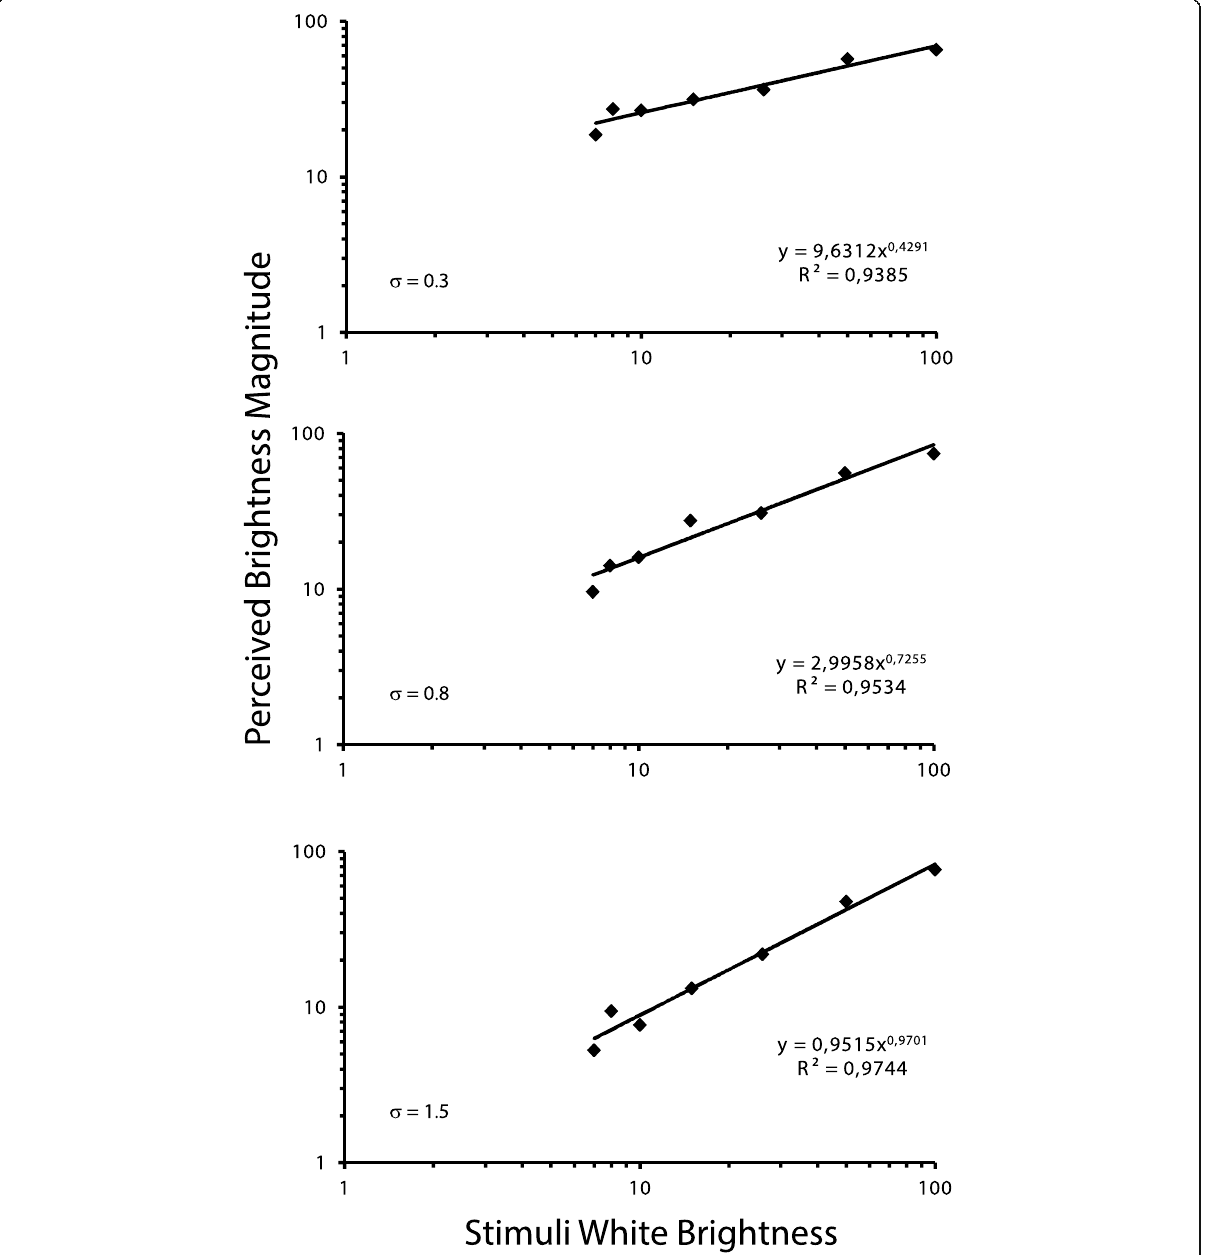
Fig. 2 Brightness magnitude perceived for circles with different contrast levels in 3 edge filtering conditions ( σ = 0.3; σ = 0.8; σ = 1.5). As the filtering increases, the higher the exponent changes from 0.43 to 0.73 and to 0.97, respectively. The increasing on the power law exponent indicates the weakening of the edge influence on the brightness of the